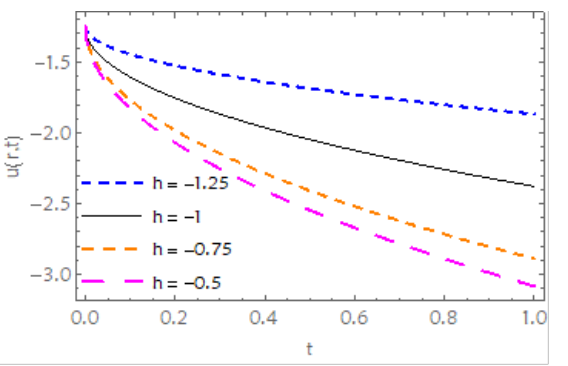
Fig. 12: h -curve of solution u ( r , t ) Vs. (cid:126) when t = 0.01, r = 1, n = 3 for Ex.